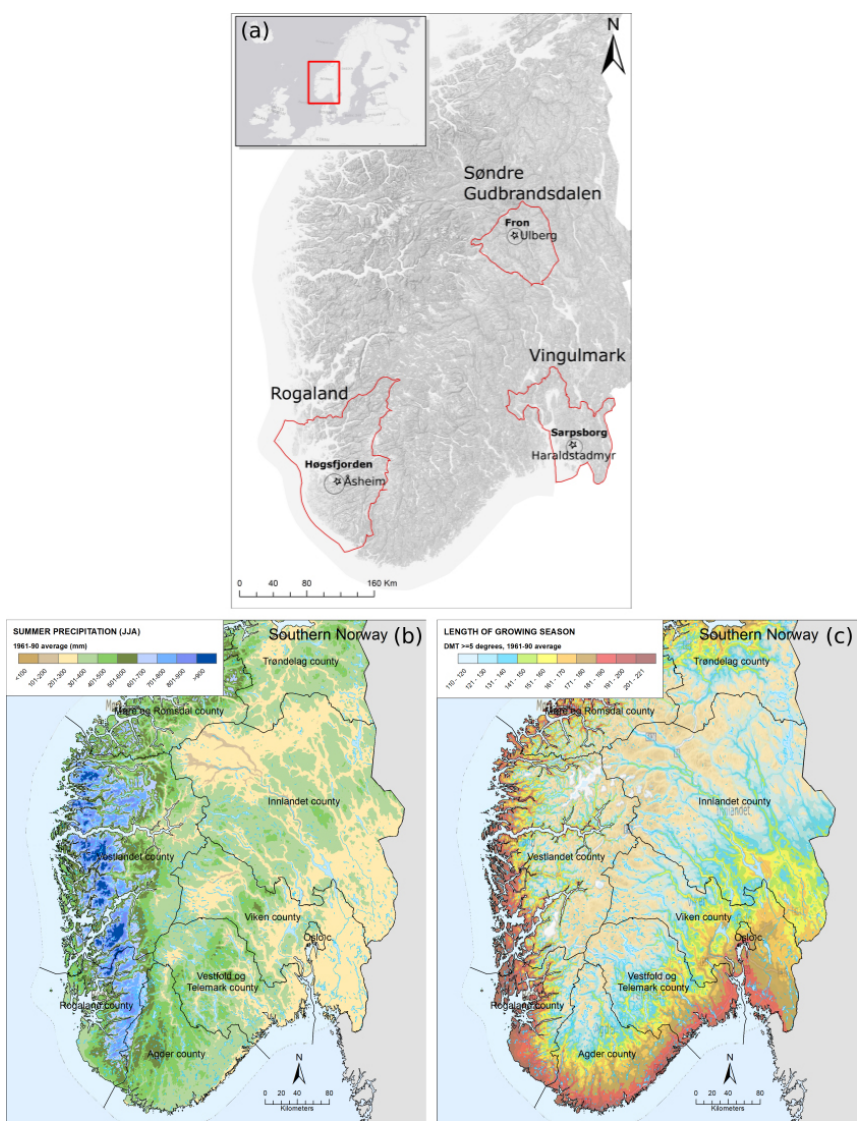
Figure 1. (a) The three case study areas and associated sites. The red outline indicates the regions, bold names indicate the areas, and the stars indicate the locations and names of the bogs analyzed for pollen. DEM map from ESRI 2020. (b) The summer precipitation and (c) average length of the growing season (days) for southern Norway during 1961–1990 for days with a daily mean temperature (DMT) at or above 5 ◦ C.